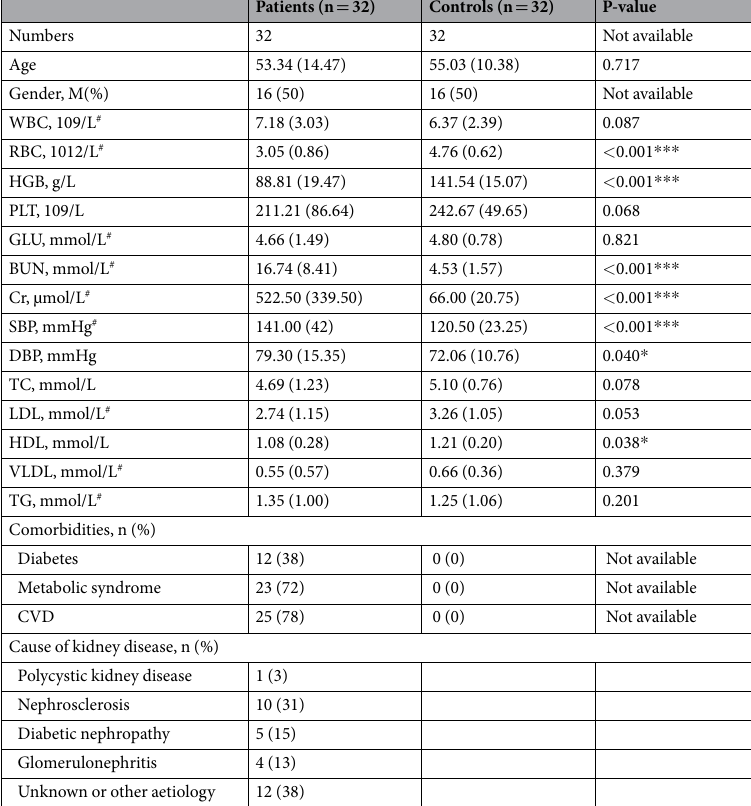
Table 1. Characteristics of the study participants. Data represent the mean (standard deviation), and the data # represent the median (interquartile range). For all records, the P values represent the results of the Mann- Whitney U test. WBC, white blood cell count; RBC, red blood cell; HGB, haemoglobin; PLT, platelet; GLU, glucose; BUN, blood urea nitrogen; Cr, creatinine; SBP, systolic blood pressure; DBP, diastolic blood pressure; TC, total cholesterol; LDL, low-density lipoprotein; HDL, high-density lipoprotein; VLDL, very low-density lipoprotein; TG, triglycerides; CVD, cardiovascular disease. * P < 0.05; ** P < 0.01; *** P <